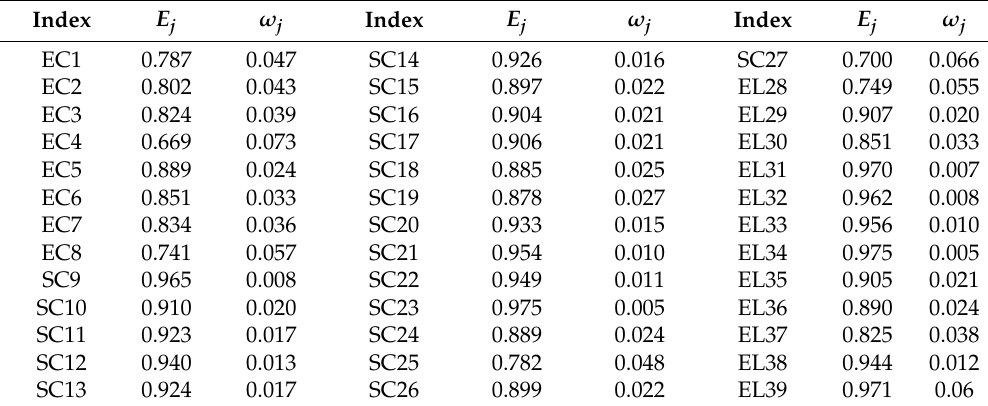
Table 4. The weight of each index using the entropy method.